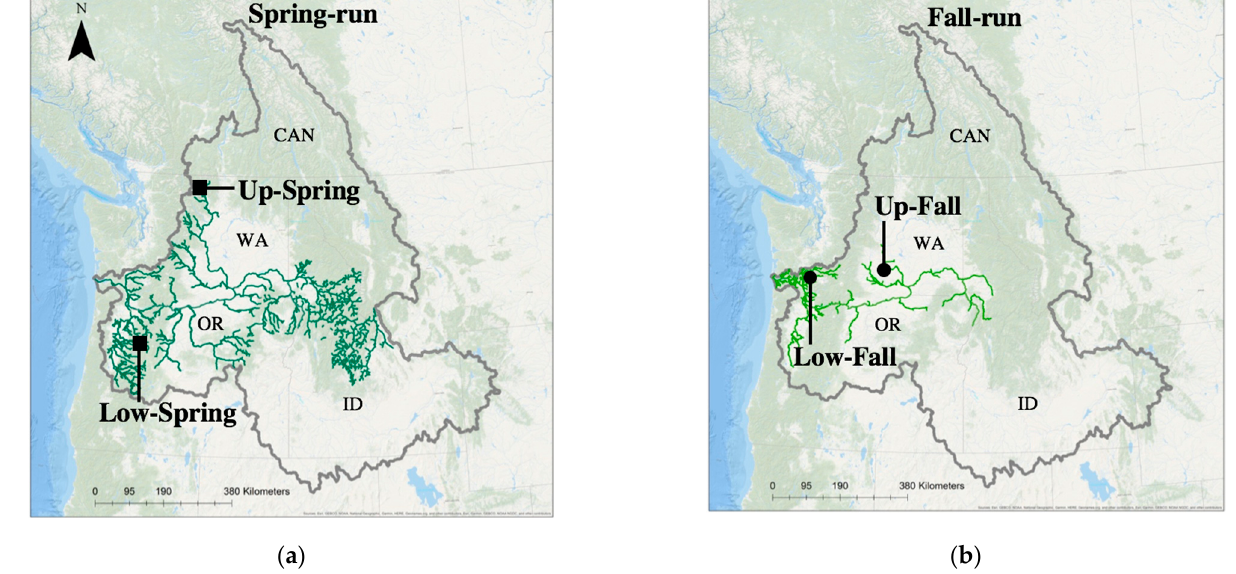
Figure 1. Maps of the Columbia River Basin (outlined in grey) of the northwestern United States and southwestern Canada showing rivers and streams (green lines) containing spring-run ( a ) and fall-run ( b ) populations of Chinook Salmon. Spring-run Chinook salmon migrate to the upper, interior reaches of the basin and spawn in smaller tributary streams, whereas fall-run salmon spawn in larger, mainstem rivers. The lower Columbia Basin (“Low”) lies west of the Cascade Mountain Range, and the upper Columbia Basin (“Up”) lies east of the Cascade Mountains. Spatial distributions of the Chinook salmon populations were sourced from StreamNet GIS Data [10]. Source locations for the four Chinook salmon populations tested here are shown.